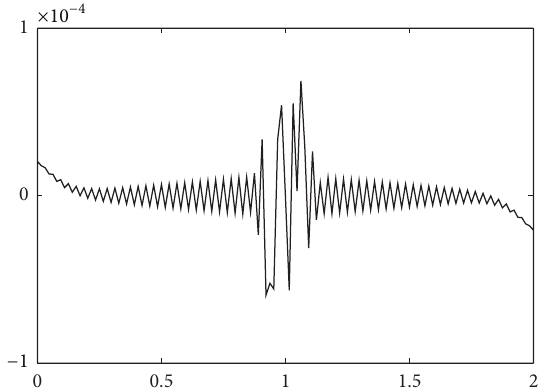
Figure 4: The computational error of the Adams-Bashforth-Moulton method ( 𝑡 = 0.4 ).